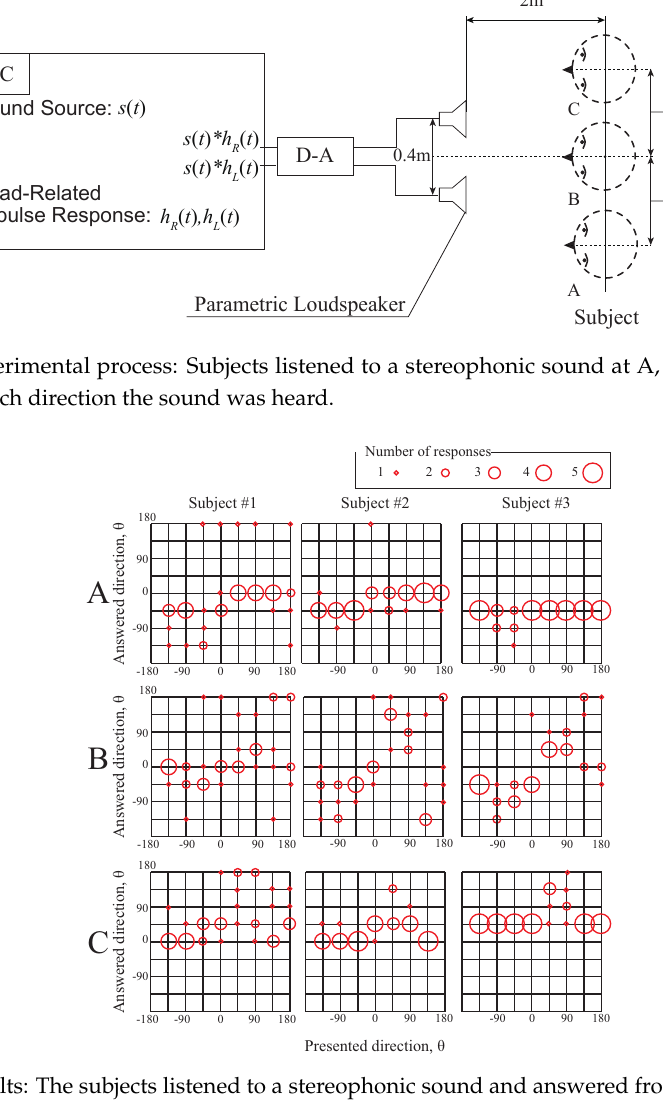
Figure 12. Results: The subjects listened to a stereophonic sound and answered from which direction the sound was heard. A, B and C are the same as in Figure